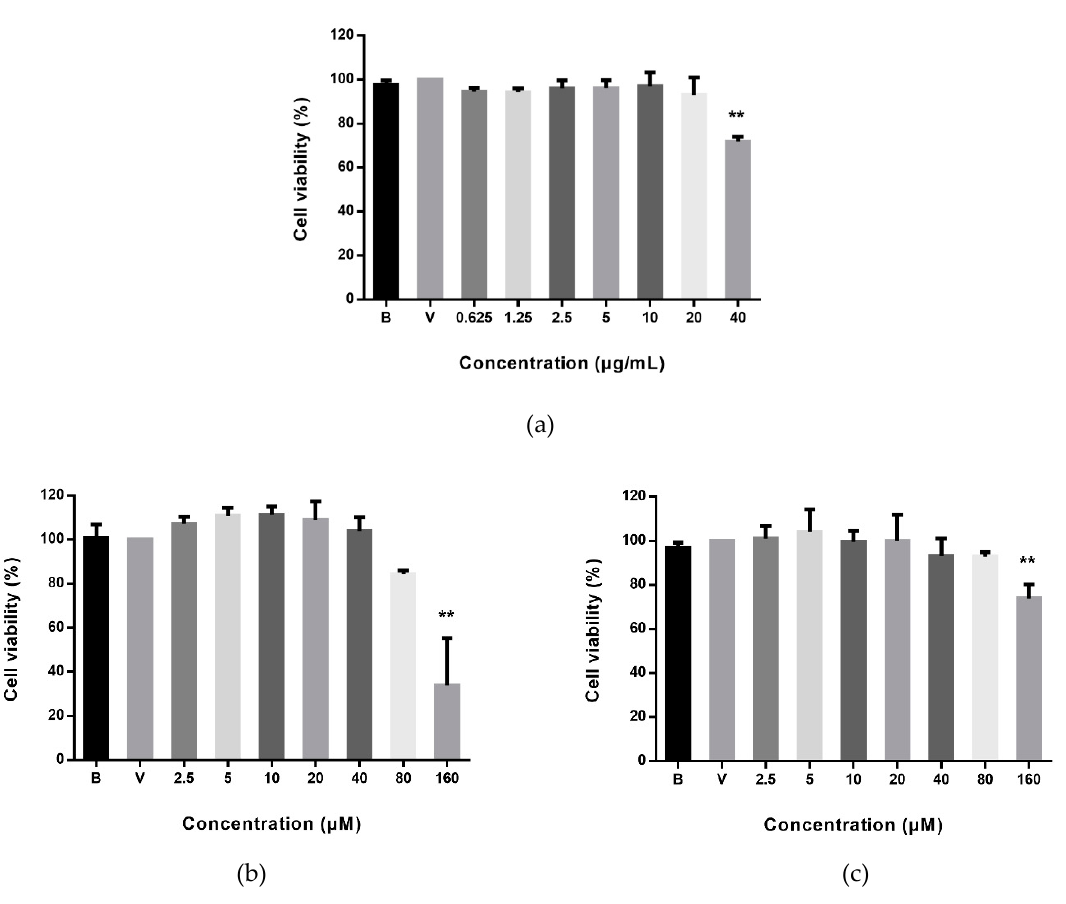
Figure 2. Cell viability of RAW264.7 cells after 24 h treatment of ( a ) AZ-SFE, ( b ) ligustilide, and ( c ) 6-gingerol detected by MTT assay. B represented medium group and V represented vehicle control group. Data are expressed as mean ± SD ( n = 5) of three independent experiments. ** p < 0.01 versus vehicle control group.